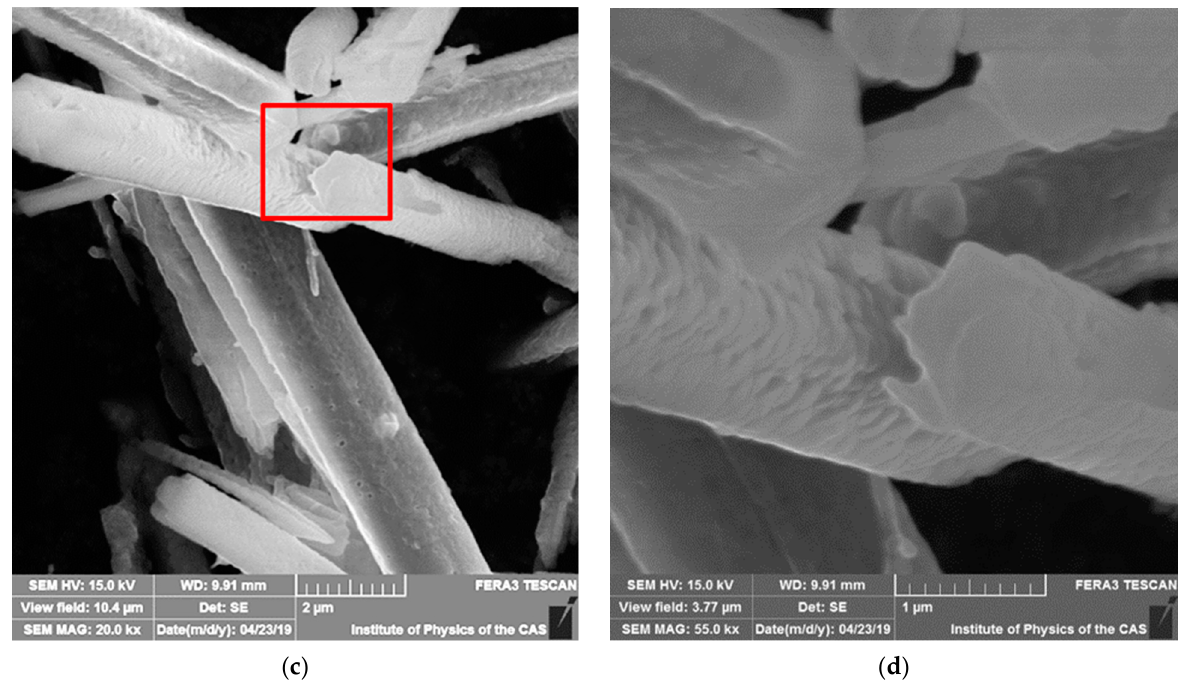
Figure 5. SEM images of the Cu/TiO 2 _800 sample, ( a ) Cu/TiO 2 _800 with a magnification of 12,000×, ( b ) Cu/TiO 2 _800 detail of nanocavities, ( c ) Cu/TiO 2 _800 with a magnification of 20,000×, ( d ) Cu/TiO 2 _800 surface detail.